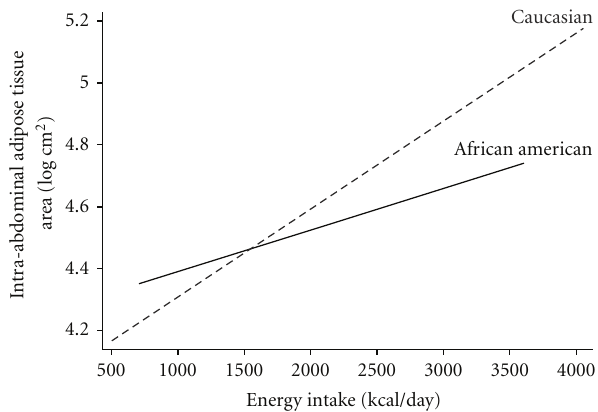
Figure 1: Intra-abdominal adipose tissue and energy intake in African American (solid line) and Caucasian (dashed line) women, adjusted for physical activity, menopausal status, smoking, income, age, and percent body fat (the predicted IAT values were calculated based on Model 3 described in Table 2). Energy intake by ethnicity interaction β = − 0 . 120, P = 0 .